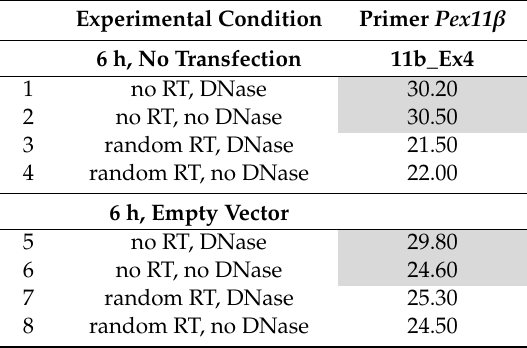
Table 5. High amounts of plasmid DNA lower the purity of the RNA during standard isolation with RNazol ® RT. MC3T3-E1 cells were transfected with a transfection reagent only (no transfection) or an empty vector (empty vector). Without RT, the Pex11 β exon primer (11b_Ex4) detected only contaminating genomic Pex11 β DNA. RNA samples of empty vector-transfected cells (compare the ct values in lines 5 vs. 6), but not of non-transfected cells (compare the ct values in line 1 vs. 2) were contaminated with residual